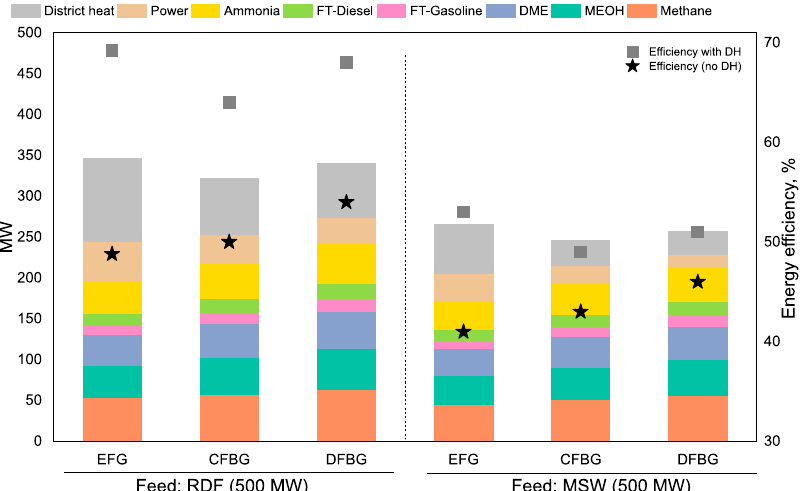
Figure 14. Power, biofuels and heat distribution from RDF and MSW gasification in three gasifiers (EFG, CFBG; and DFBG). Feed = 500 MW; an equal amount of syngas was transferred for biofuels and power production in each case.